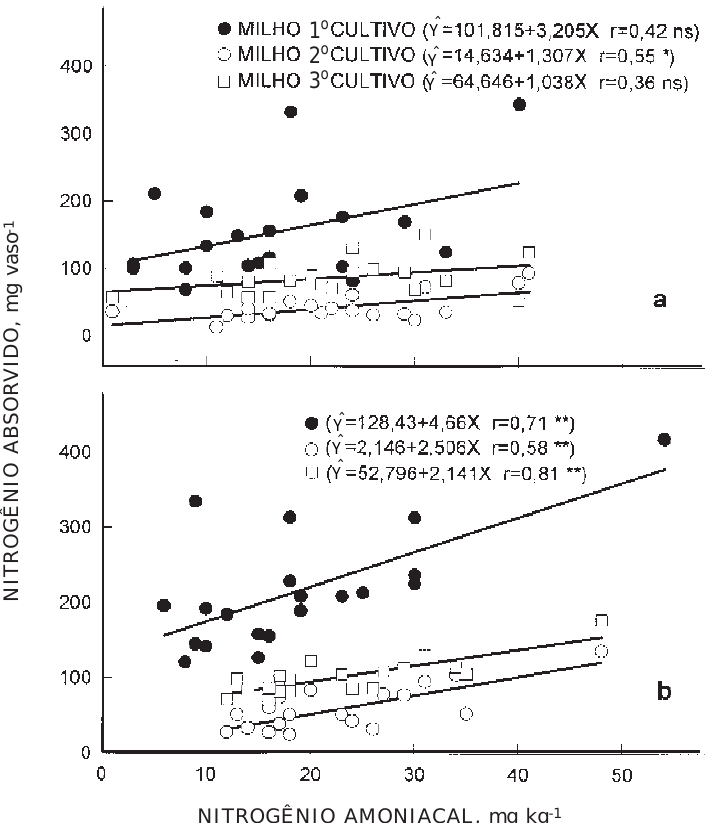
NITROGÊNIO AMONIACAL, mg kg Figura 1. Correlação linear entre o teor de nitrogênio disponível estimado pela extração do solo sem calagem (a) e com calagem (b) com uma solução de KCl 2 mol L -1 por quatro horas e a quantidade de N absorvido pelas plantas de milho em três cultivos. ns (p > 0,05), * (p < 0,05), ** (p < 0,01).